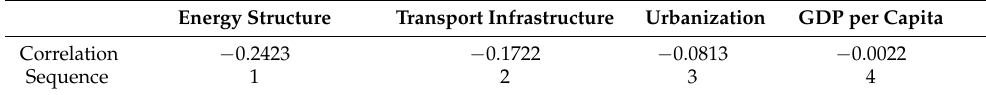
Table 7. Correlation measurement